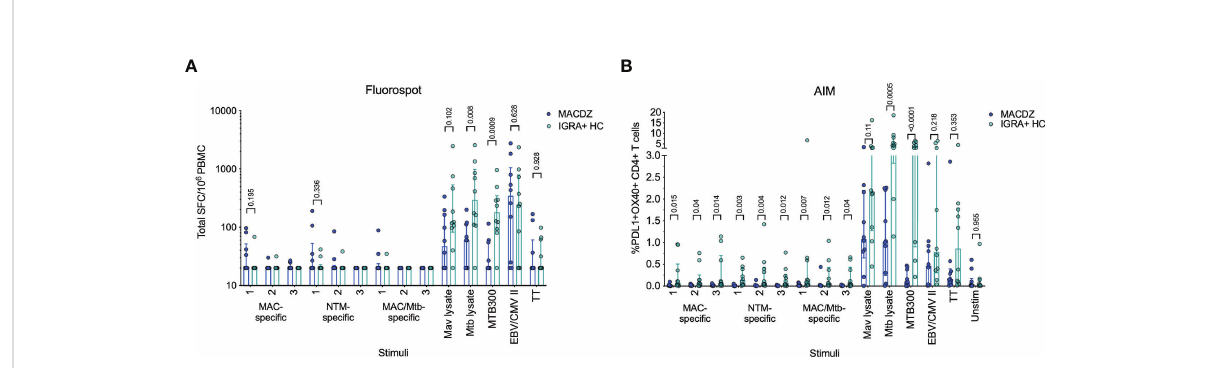
FIGURE 1 Individuals with MAC disease have infrequent Mav- or mycobacteria-speci fi c responses. (A) Total magnitude of response (sum of IFN g , IL-5 and IL-17) against peptide pools, Mav and Mtb lysates as SFC per 10 6 cultured PBMC as determined by Fluorospot. Each point represents one participant (MACDZ, n = 10 in blue; IGRA+HC, n = 10 in teal), median ± interquartile range is shown. Two-tailed Mann-Whitney test, comparisons without a p-value indicated were not signi fi cant. Limit of detection is 20 SFC. (B) Frequency of PDL1+OX40+ CD4 T-cells in response to peptide pools, Mav and Mtb lysates. Each point represents one participant (MACDZ, n = 10; IGRA+HC, n = 10), median ± interquartile range is shown. Two-tailed Mann-Whitney test. CD4 T-cells were gated as CD3+CD4+CD8-CD19-CD14- in the live singlet gate of